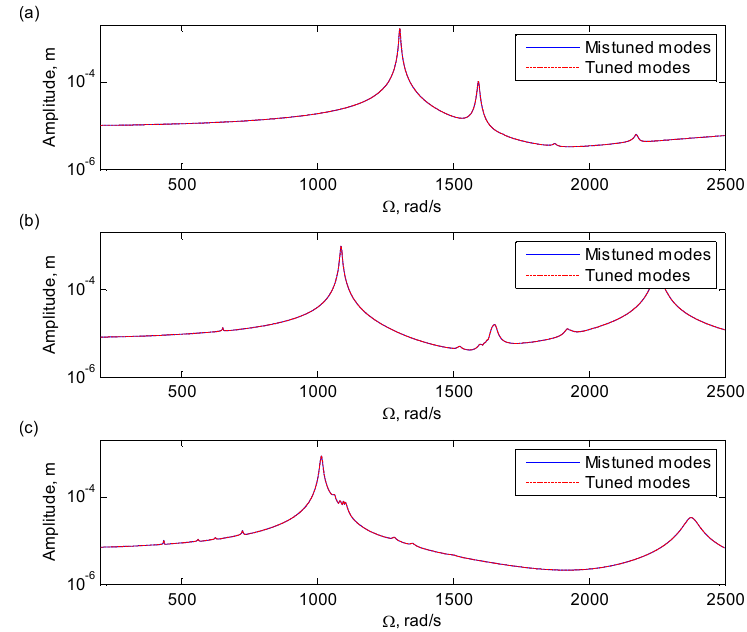
Figure 3. Comparisons of the forced responses of the excitation nodes of the assembly using the normal modes of the mistuned case and those of its tuned counterpart with excitations of ( a ) one engine order (1EO), ( b ) 2EO, and ( c ) 3EO.